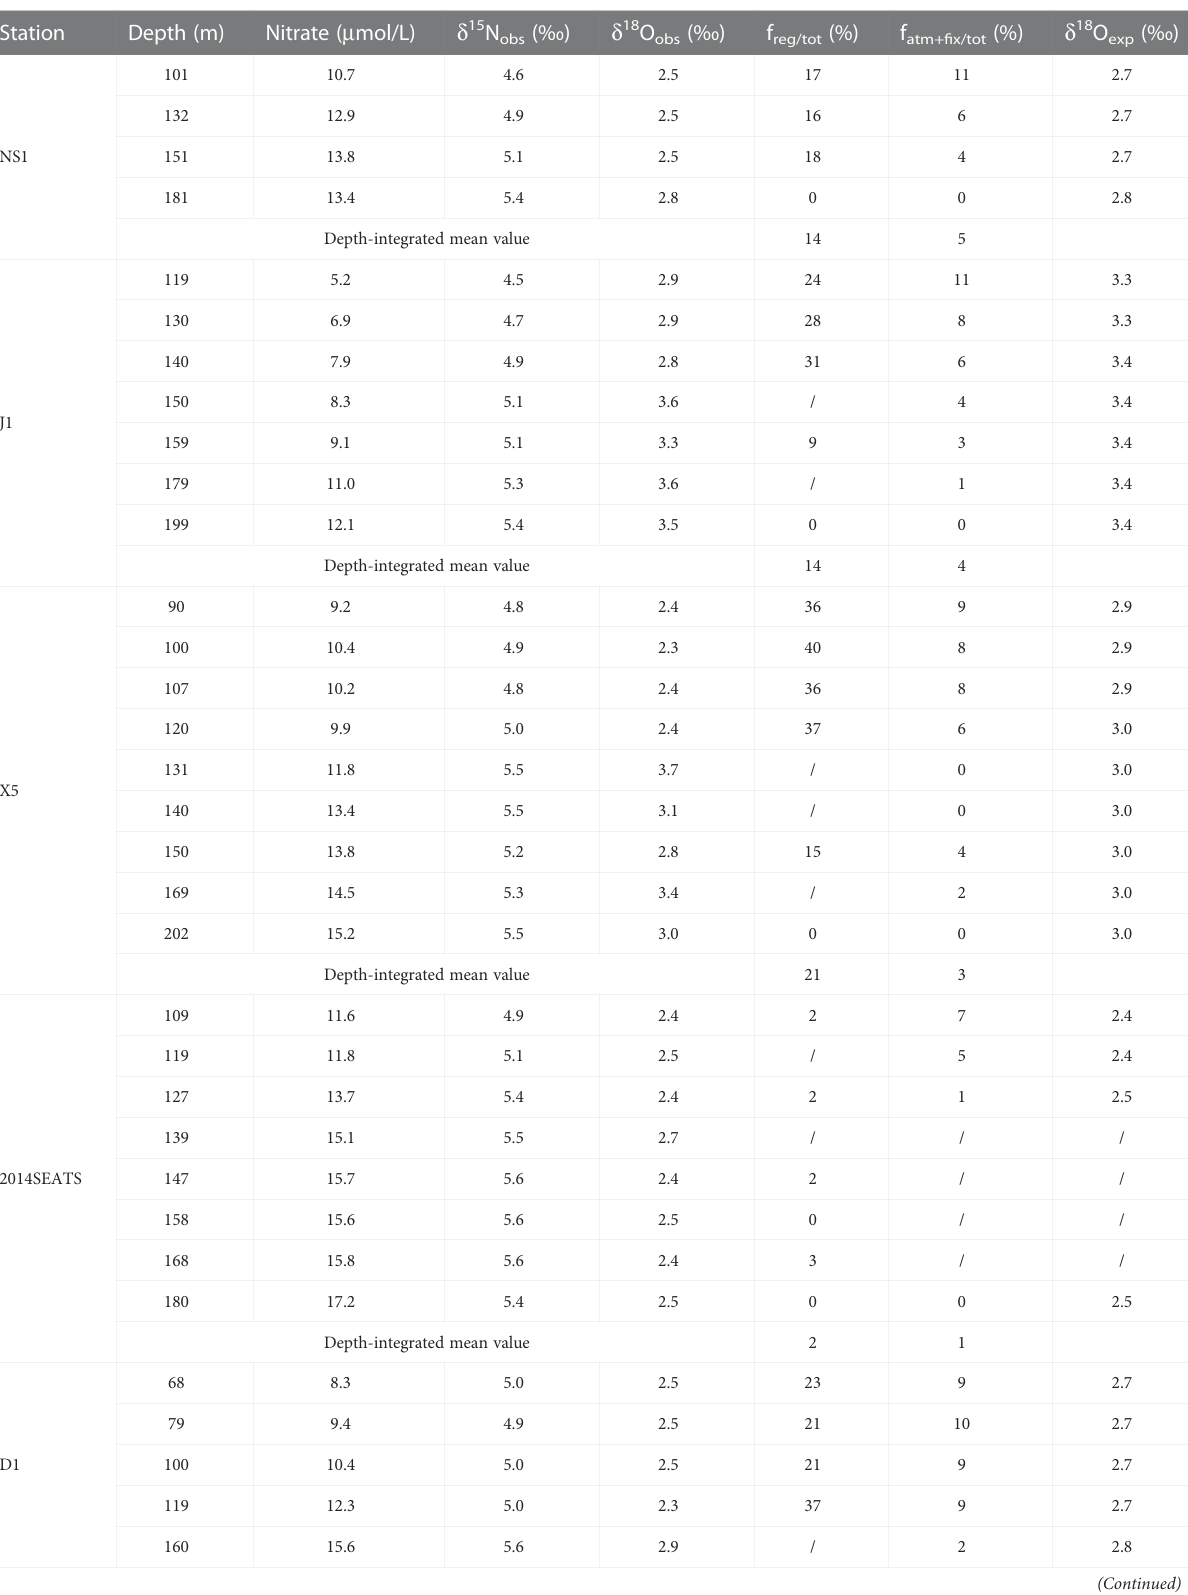
TABLE 3 Summary of the proportions of regenerated NO 3 – (f reg/tot ) and external N inputs from AND/N 2 fi xation (f atm- fi x ) in the Dd 18 O NO3 -negative layer.